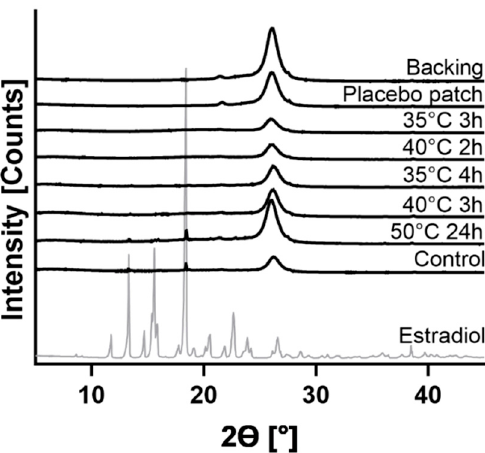
Figure 1. Contour plot of the effect of drying time and temperature on the residual amount of DMSO/patch. The line with the value 9 displays the maximum amount of DMSO (9 mg) which can be incorporated to produce a suitable transdermal patch.